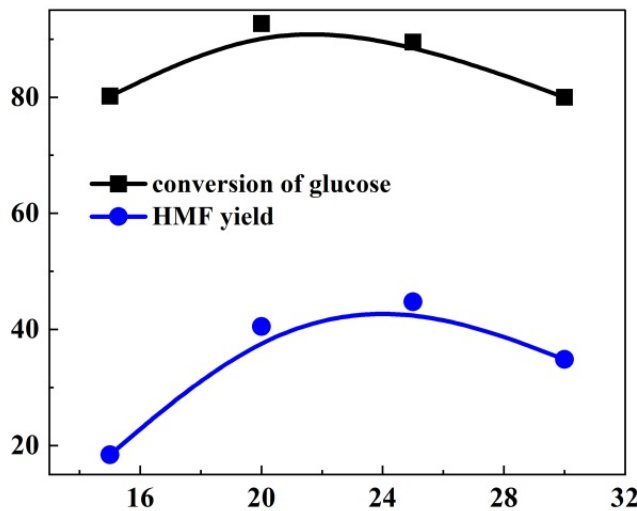
Figure 10. Effect of amount of decanoic acid on HMF production from glucose.